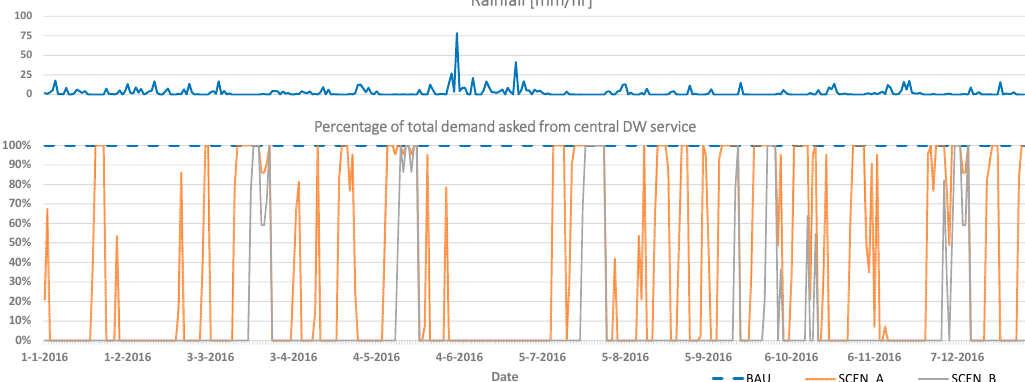
Figure 9. Time-series of the decentralized system DW autonomy for both design options.